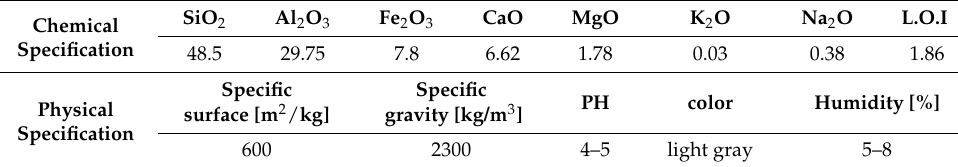
Table 4. Physical and chemical specification of FA.